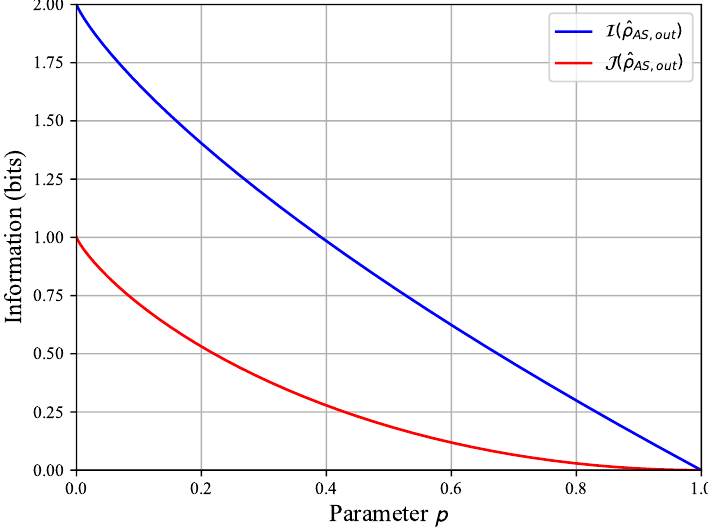
Figure 5. The quantum mutual information I ( ˆ ρ AS,out ) in blue and the classical information J ( ˆ ρ AS,out ) in red as functions of the parameter p ∈ [ 0, 1 ] for ξ = 1 / 2